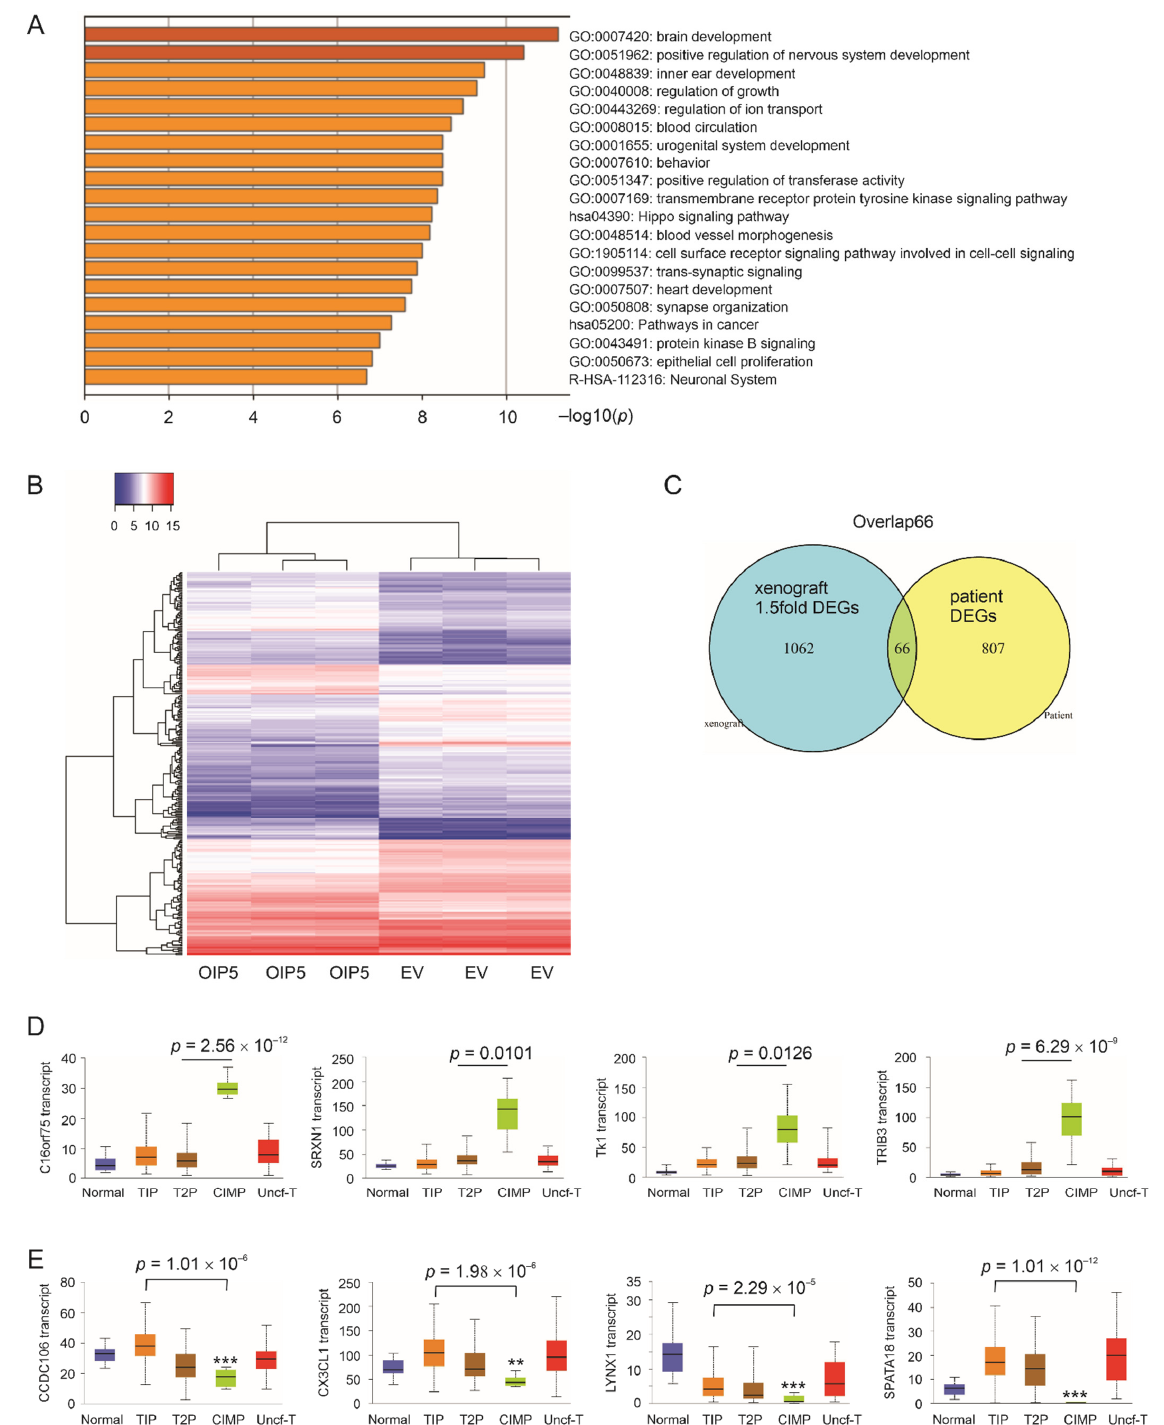
Figure 4. Pathway enrichment of OIP5 DEGs. DEGs were first defined as p.adj < 0.05 and fold changes > |1.5| in the comparison of ACHN OIP5 tumors ( n = 3) vs. ACHN EV tumors ( n = 3). ( A ) Pathway enrichment in these DEGs (Table S3) was then performed using the Metascape [34] platform. ( B ) Clustering of DEGs in ACHN OIP5 tumors and ACHN EV tumors. ( C ) The number of overlapping genes between primary (patient) pRCC-derived DEGs and DEGs obtained from xenografts at fold change > |1.5|. ( D , E ) The indicated DEGs were analyzed for expression in the histological subtypes of pRCC using the UALCAN platform [37]. DEGs positively ( D ) and negatively ( E ) predict shortening of OS (see Table 2 for details). **: p < 0.01, ***: p < 0.001 in comparison to normal kidney